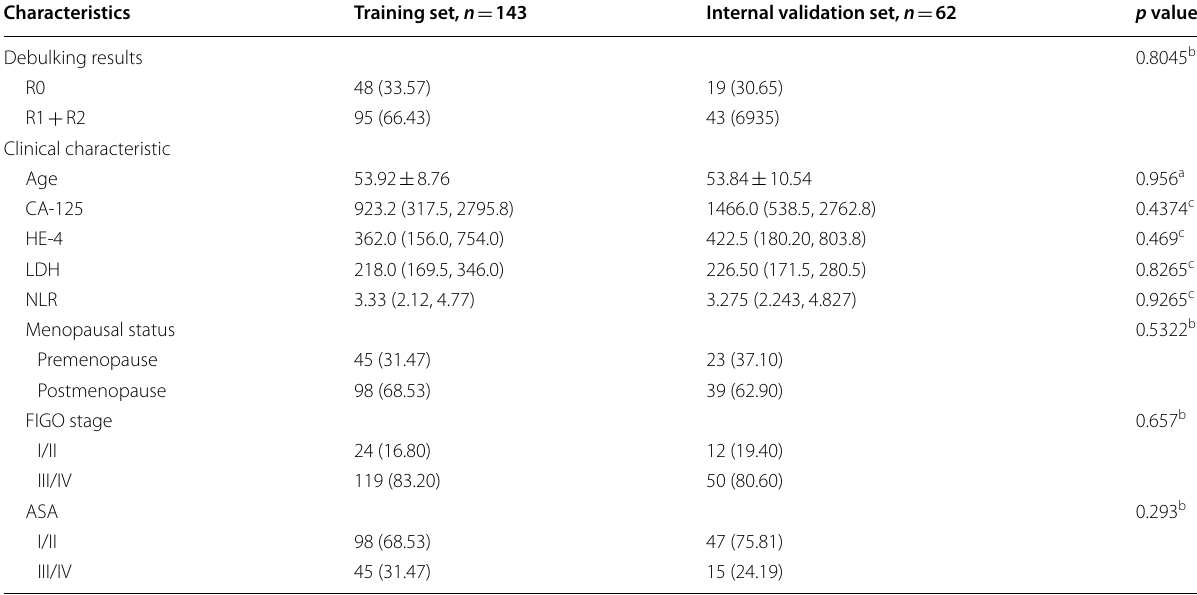
SOC Serous ovarian carcinoma, R0 no residual disease, R1 a residual disease with a maximum diameter of of > 1 cm; FIGO International Federation of Gynecology and Obstetrics, ASA American Society of Anesthesiologists Classification a Two independent samples Student’s t test b Chi-squared test c Wilcoxon’s